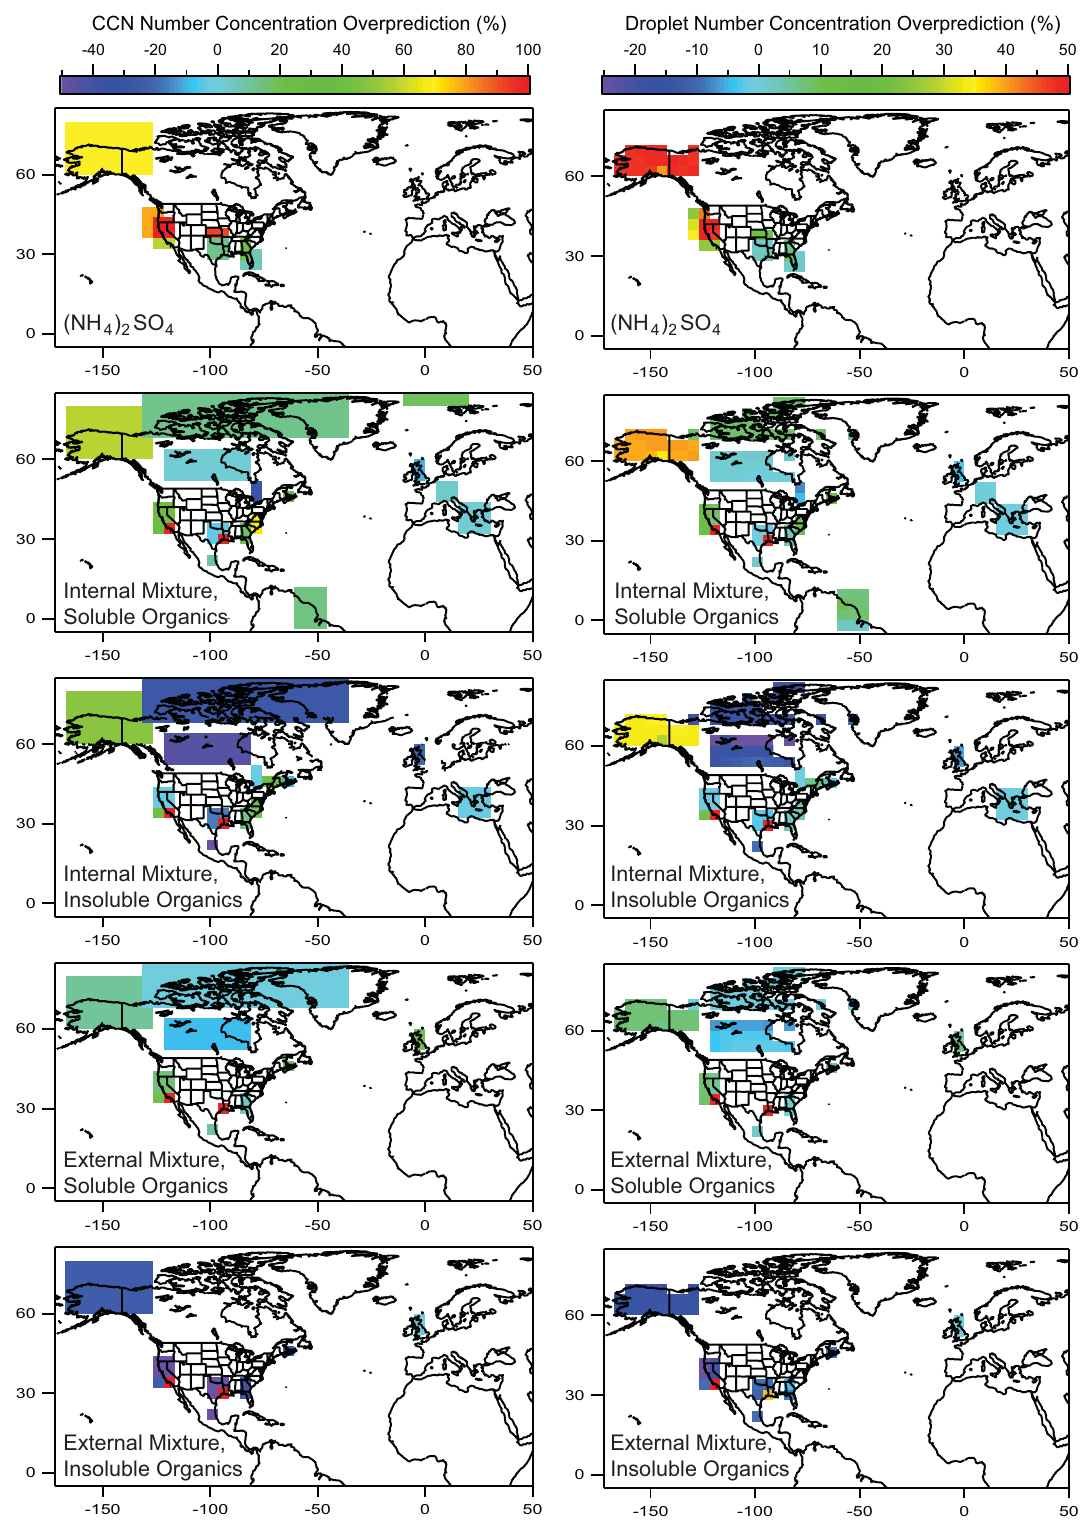
Fig. 4. Regional spatial distribution of measured N CCN uncertainties derived from the closure studies (left) and the N d uncertainty found by multiplying the measured 1N CCN